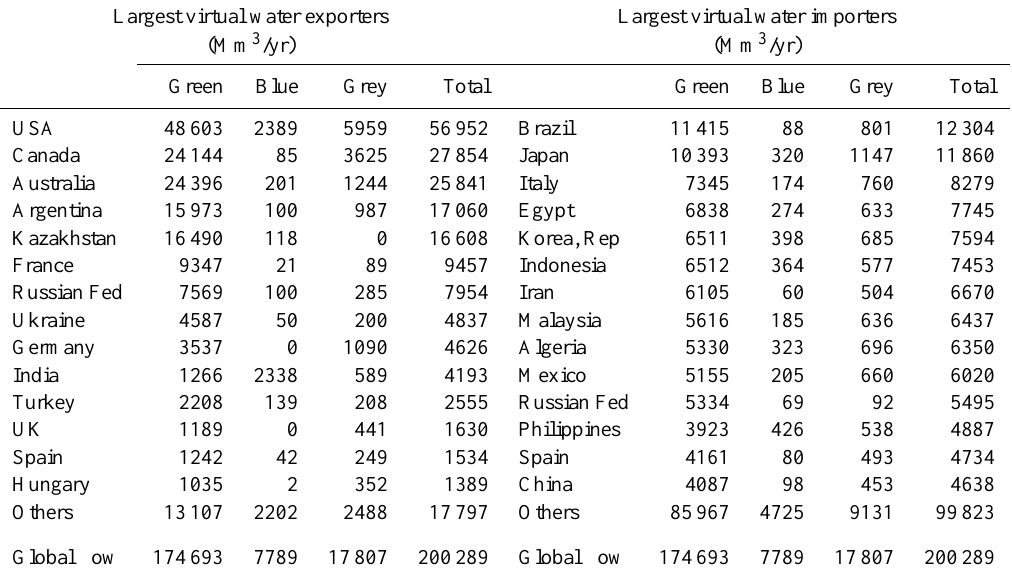
Table 4. Gross virtual water export and import related to the international trade of wheat products in the period 1996–2005.